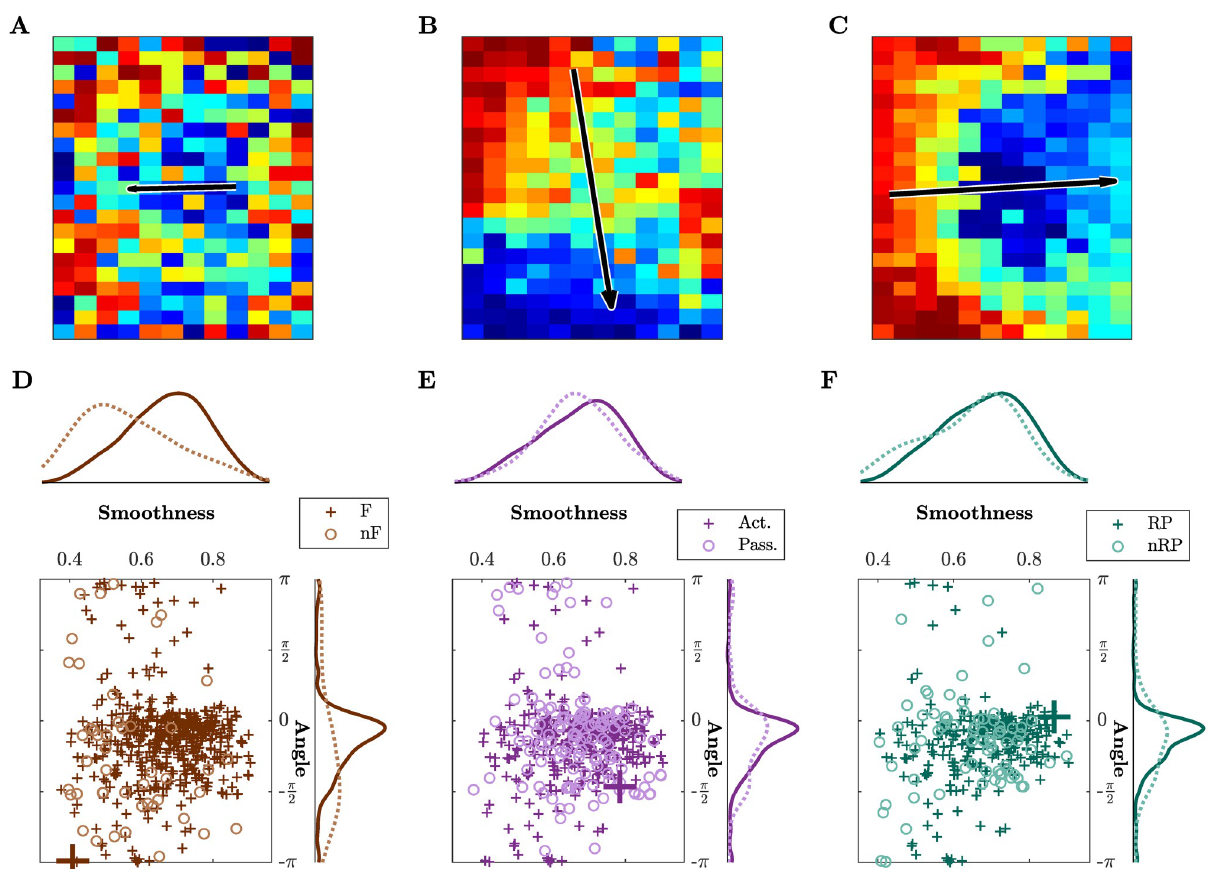
Fig 3. Propagation pattern varies across event types in healthy mice. (A-C) Three different patterns with increasing smoothness and varying angle. Note that the length of the arrow is proportional to the smoothness. (A) Low smoothness identifies a poor propagation pattern without any proper directionality. (B) High smoothness identifies a clear pattern and corresponding directionality. (C) High smoothness and horizontal propagation in contrast with (A) low smoothness and opposite horizontal direction, and different from (B) which has still high smoothness, but an almost orthogonal angle of − π /2. (D-F) Scatter plots and histograms of smoothness and angle of propagation for all events. The events whose propagation patterns are shown in (A)-(C) are highlighted by larger markers.—Brown colors refer to force (F) and non-force (nF) events, active (Act) and passive (Pass) events are in purple, reward pulling (RP) and non-reward pulling (nRP) events in green. All plots include the events from all the sessions for one healthy mouse.